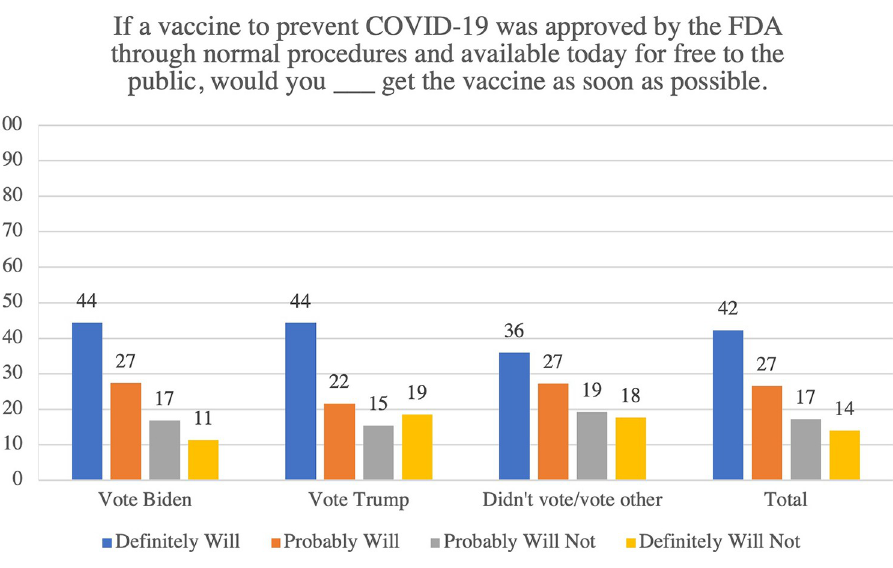
Fig 2. COVID-19 vaccination intentions by vote choice